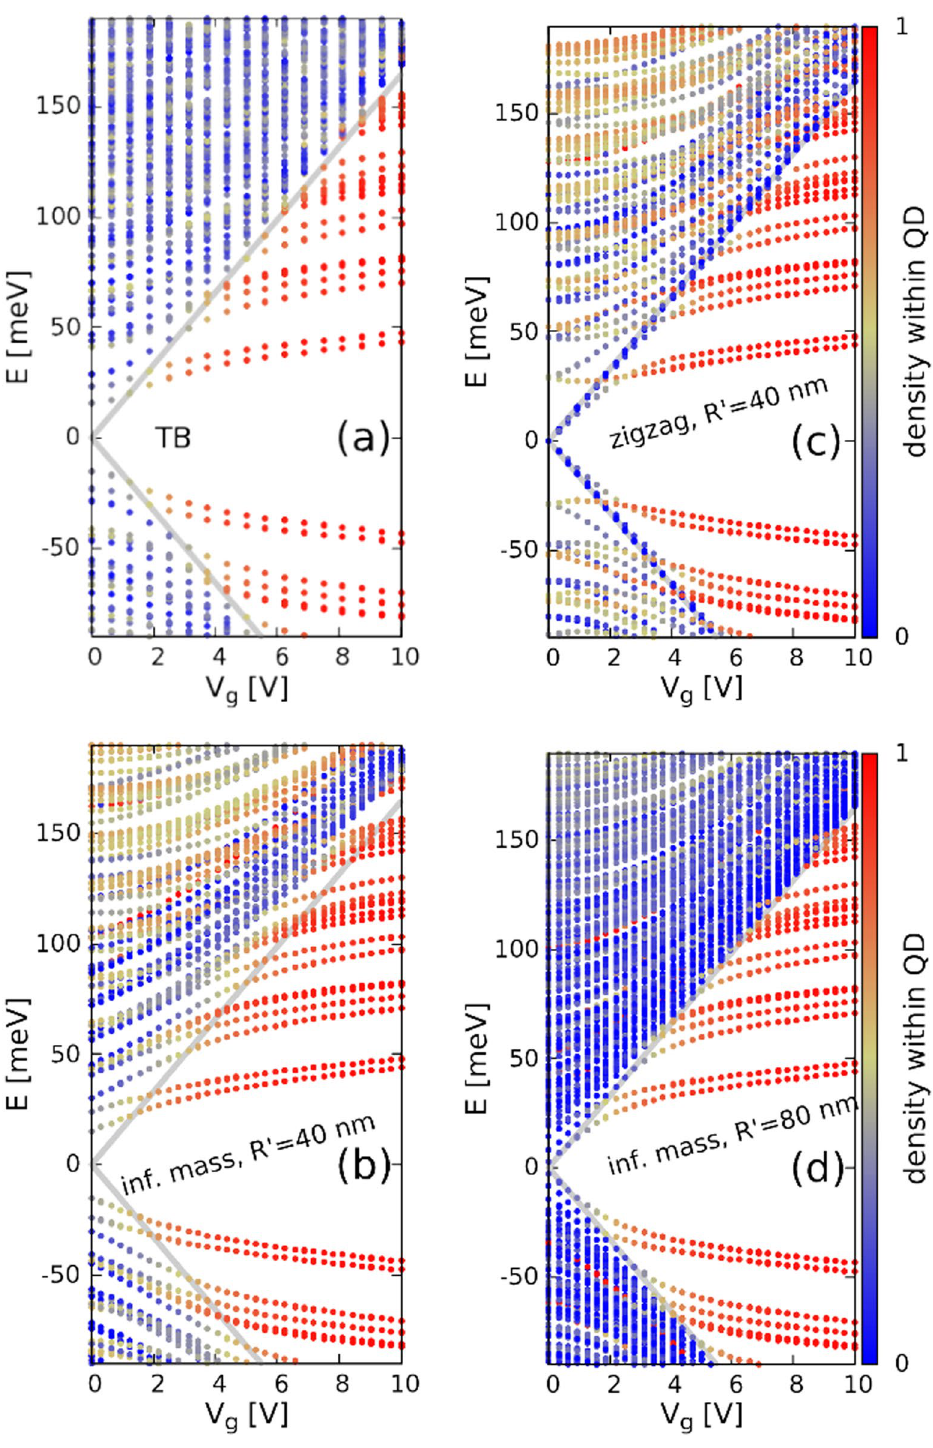
Figure 2. Energy levels of a silicene flake with a circular quantum dot of radius R = 20 nm defined in its center by the inhomogeneous vertical electric field as functions of the gate voltage applied as in Fig. 1. The plot ( a ) shows the results of the atomistic tight binding approach for the armchair hexagonal flake of side length 43 nm without the spin-orbit coupling. Plots ( b–d ) were obtained with the continuum approach for the confinement potential defined of radius R = 20 nm within a circular flake of radius R ′ = 40 nm ( b , c ) and R ′ = 80 nm ( d ). The infinite mass boundary conditions were applied at the edge of the flake in ( b ) and ( d ) and zigzag boundary conditions in ( c ). The color of the lines indicates the part of the probability density that is localized at a distance of 1.1 R from the center of the dot. The thick gray lines show the electrostatic potential energy at the A (the upper gray line with positive energy) and B (the lower gray line) outside of the quantum dot. The results are obtained for perpendicular magnetic field B = 0.5 T and the spin-orbit coupling is